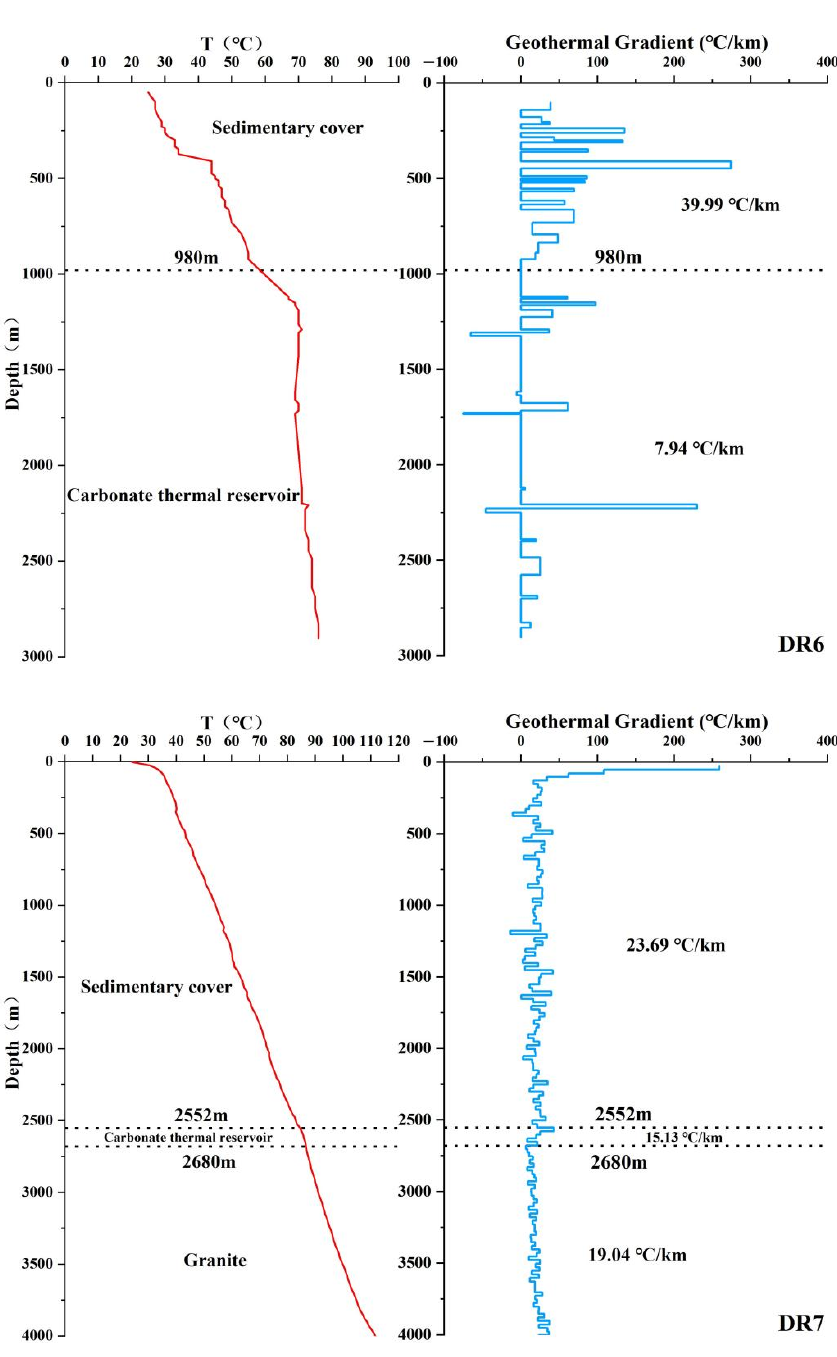
Figure 13. Variations in temperature with depth in wells DR1, DR6 and DR7.